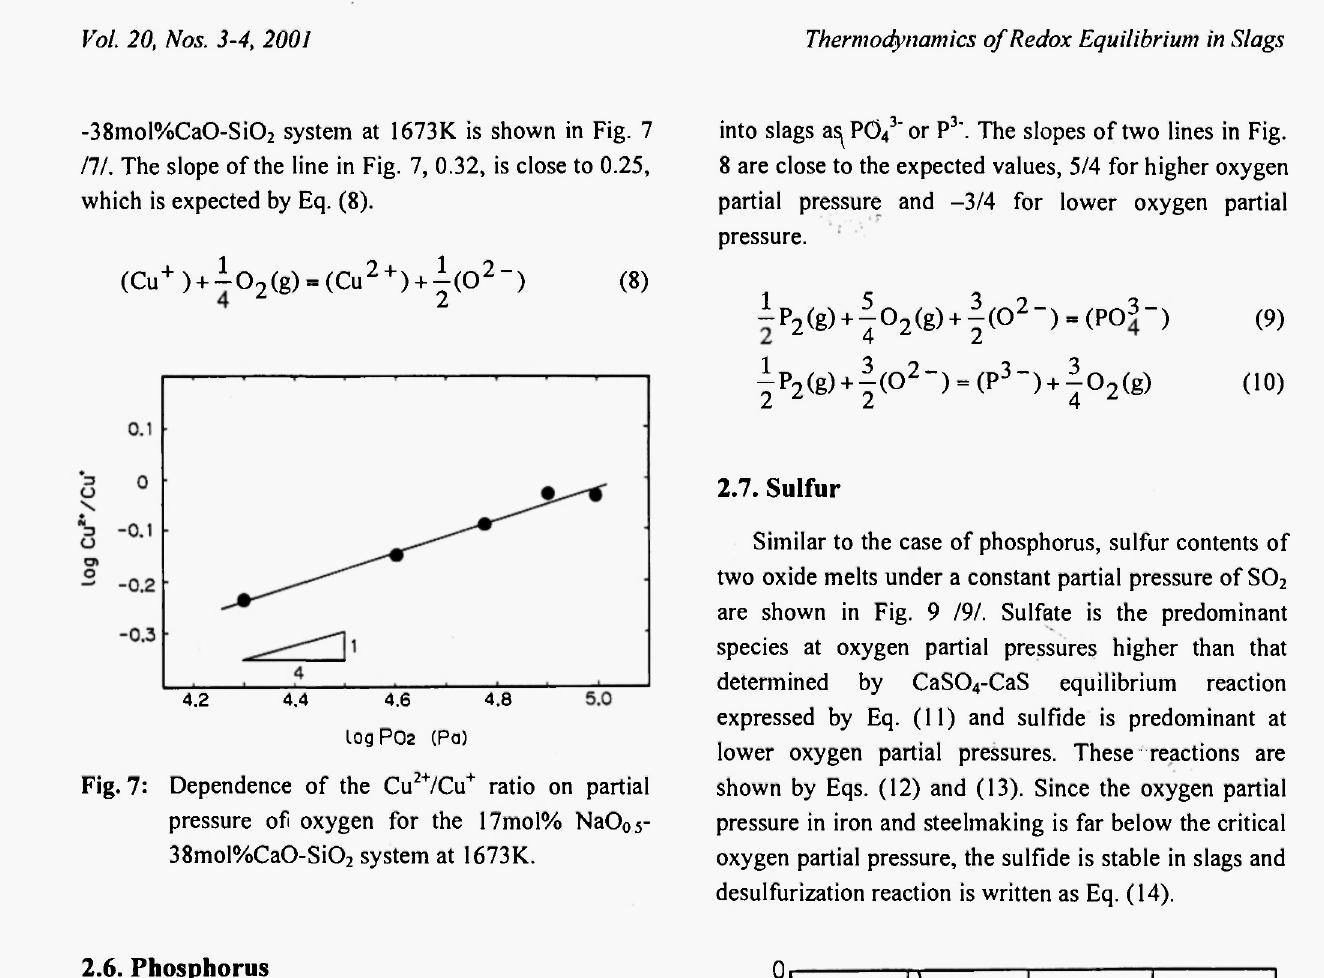
Fig. 7: Dependence of the Cu 2+ /Cu + ratio on partial pressure of oxygen for the 17mol% NaO 05 - 38mol%CaO-SiC> 2 system at 1673K.